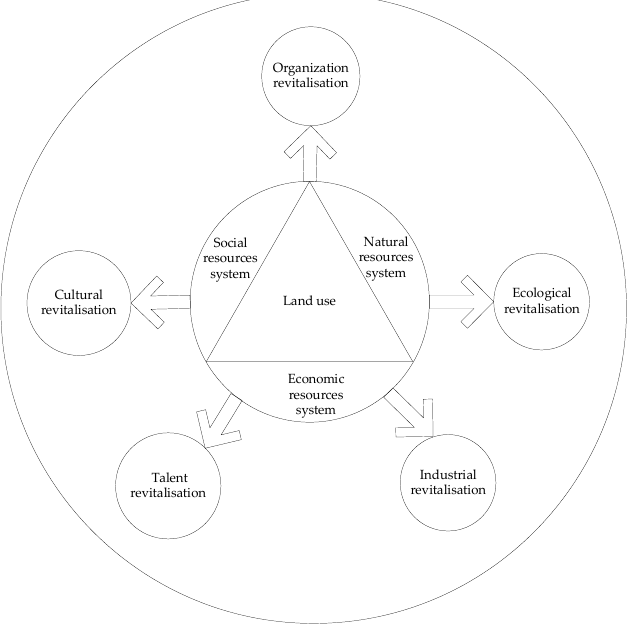
Figure 1. The framework of the relationship between land use and rural revitalization. In 2020, all rural poor people in China were lifted out of poverty, contributing to more than 70% of the world’s poverty reduction [18,19]. However, rural population out- flow, and environmental degradation still exist in rural areas. Rural development has en- tered a stage of comprehensive transformation. The 19th National Congress of the